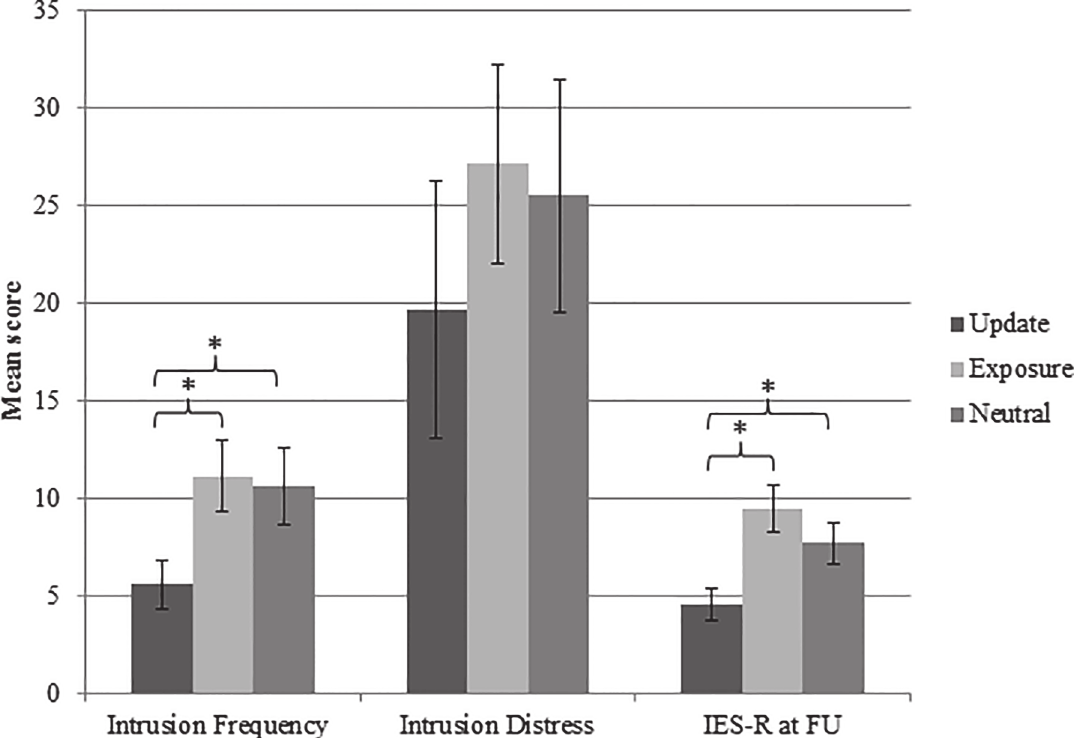
Fig 3. Verbally updating the trauma memory reduces intrusion frequency, distress and PTSD symptoms. Mean intrusion frequency, distress associated with the intrusions and PTSD symptom scores over the week following the experimental session for each group (update, exposure and control) . The update group reported significantly fewer intrusions and PTSD symptoms than the other two groups. * p < 0.05 (between updating and exposure groups or between updating and control groups). The difference in intrusion distress between the groups approached significance, p < 0.075. Error bars represent standard